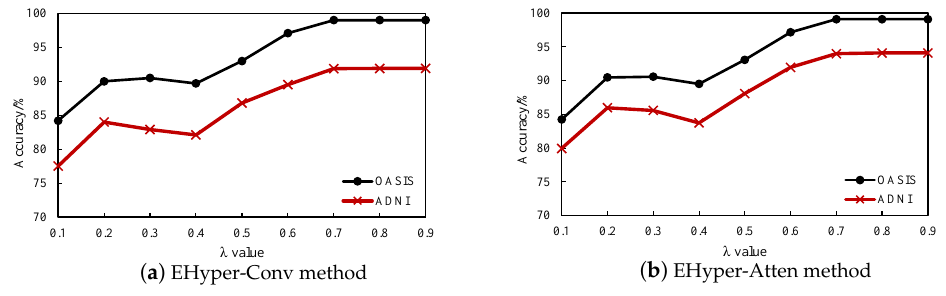
Figure 6. The effect of different λ values in two methods. Hidden representation: We also discuss the influence of hidden representation in the network on classification results. As shown in Figure 7, classification accuracy increases with the increase in hidden representation, reaches the peak when the length is 16, and then tends to be stable. Moreover, the EHyper-Conv method is always better than the Hyper- Conv and GCN methods in various feature dimensions, which indicates that the graph structure of EHyper-Conv is more robust and has better capability in graph embedding.